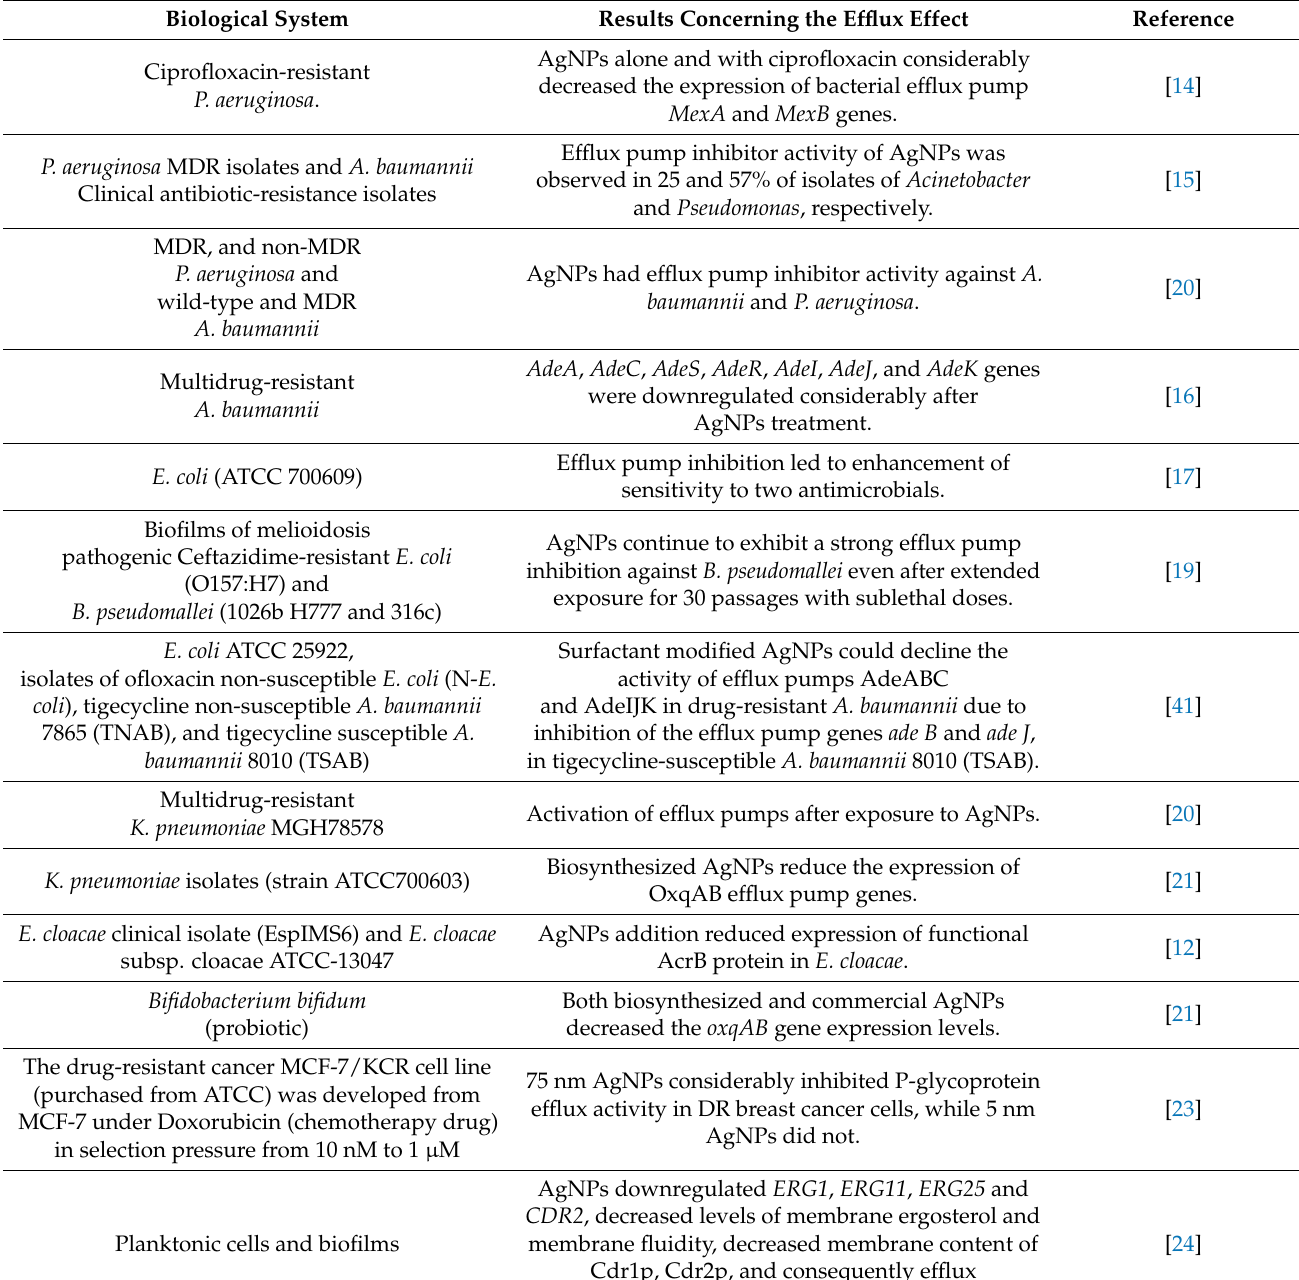
Table 4. Influence of AgNPs on the efflux effect in different biological